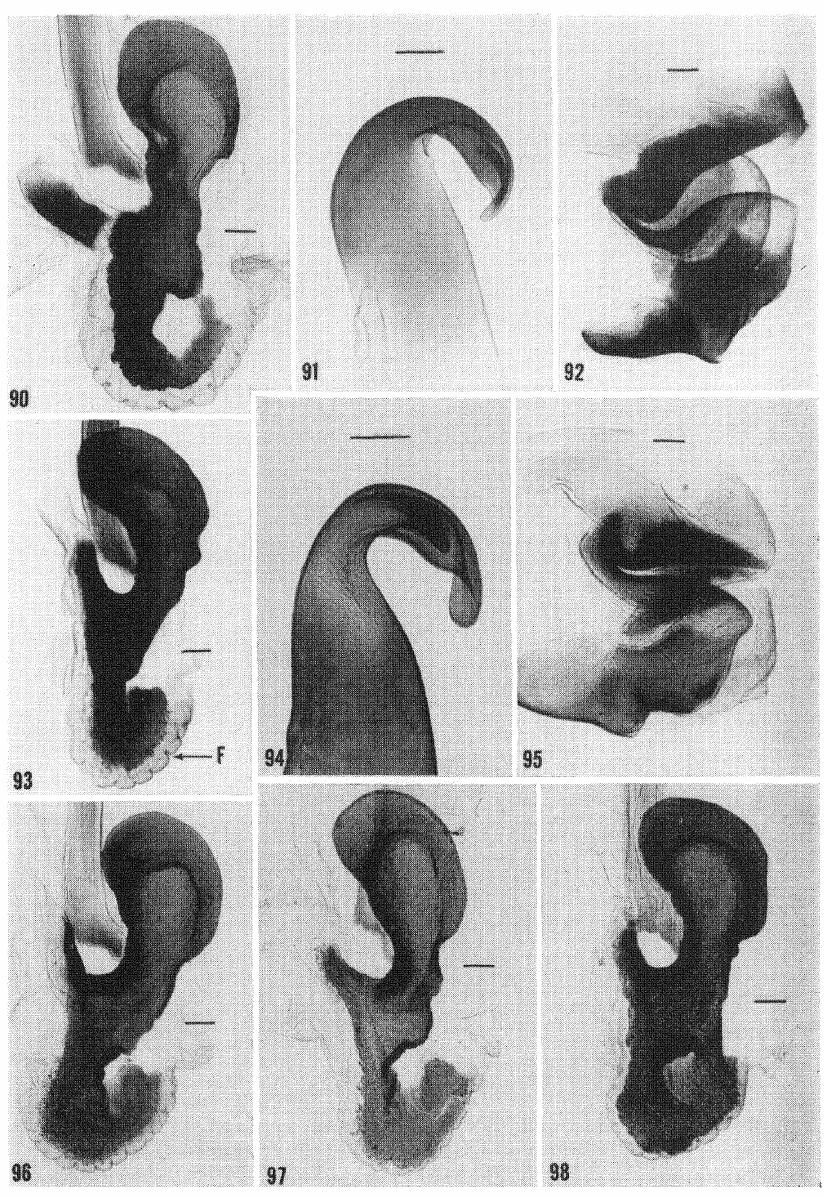
Figs. 90-98. Phort’.oeca phoraspoides (Walker). 90-92. (99 ANSP). Muzo, Colombia (det. Hebard). 93-98. (N). Laboratory culture originating from Panama. F- fringe around preputial membrane. (seale 0.2